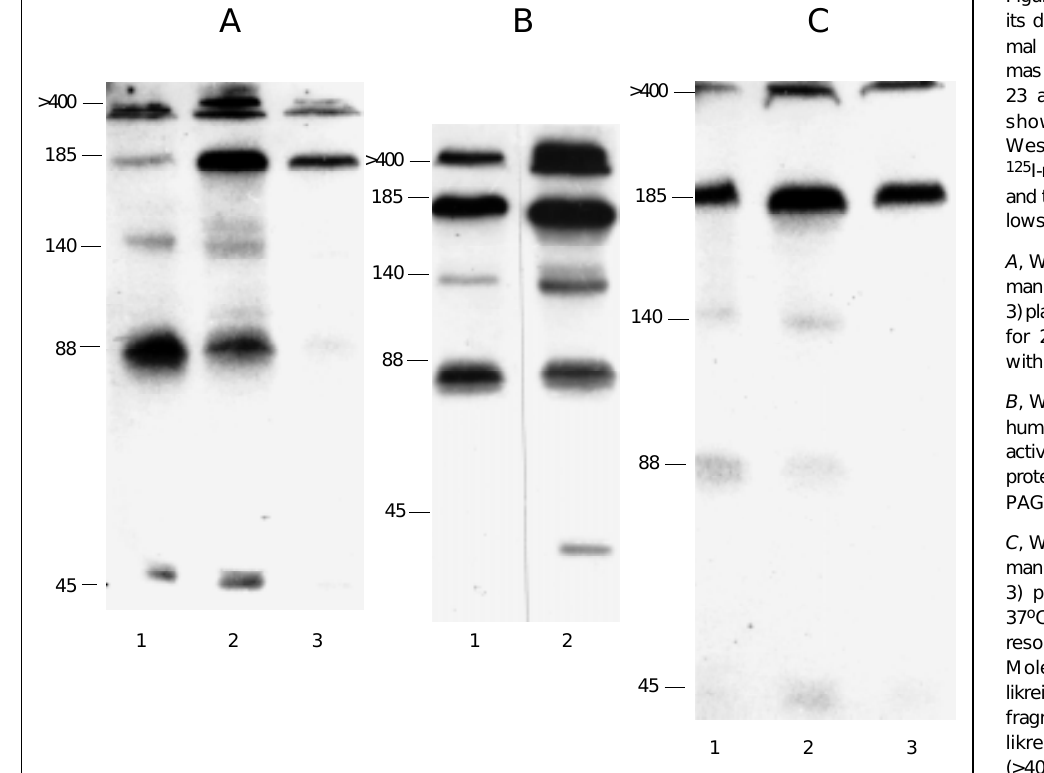
Figure 5 - Distribution of PK and its derivatives in Williams’, nor- mal human and orangutan plas- mas activated with kaolin at 4, 23 and 37 o C. Autoradiographs shown were obtained from Western blots detected with 125 I-mAb 13G11. Plasmas (8 µl) and their treatment were as fol-